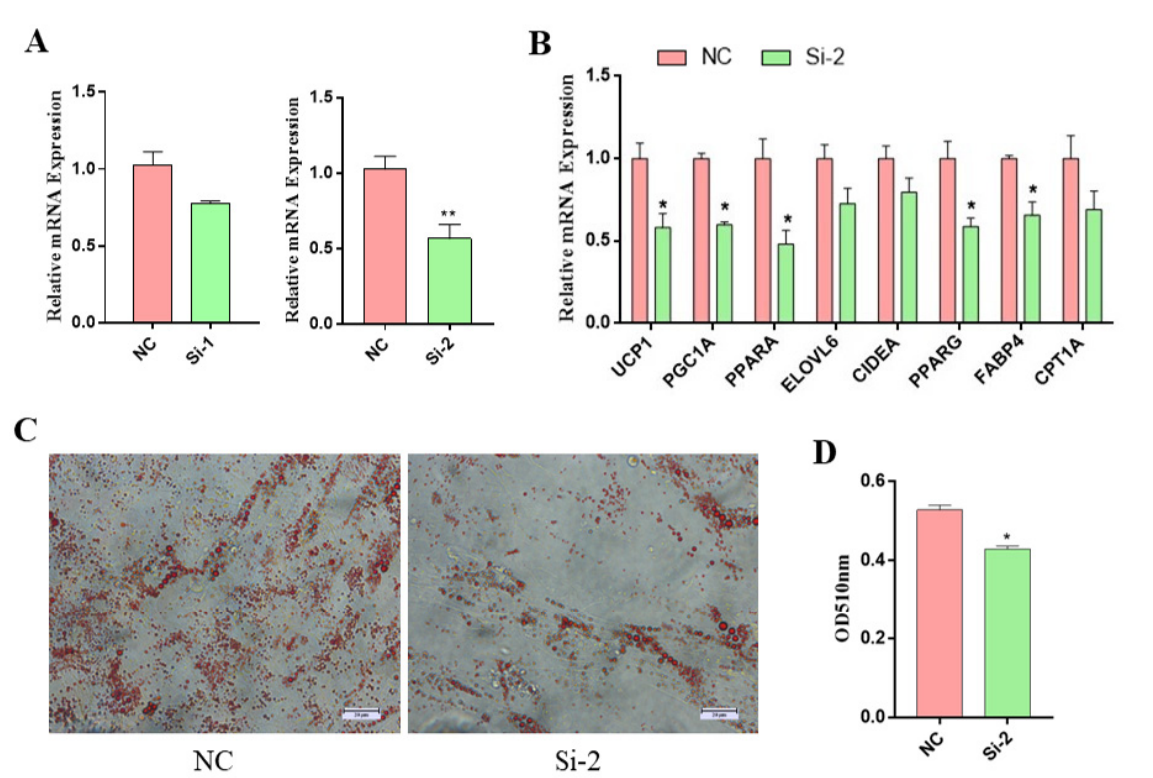
Figure 3. MSTRG.310246.1 knockdown inhibited the differentiation and thermogenesis of brown adipocytes. ( A ) Knockdown of MSTRG.310246.1 in brown adipocyte. ( B ) Gene expression in brown adipocytes transduced with NC or siMSTRG.310246. ( C , D ) Oil-red-O staining of brown adipocytes transduced with NC or siMSTRG.310246. Bar: 20 µ m. The absorbance at 510 nm was detected. Error bars represent SEM, n = 6, * p < 0.05, ** p <